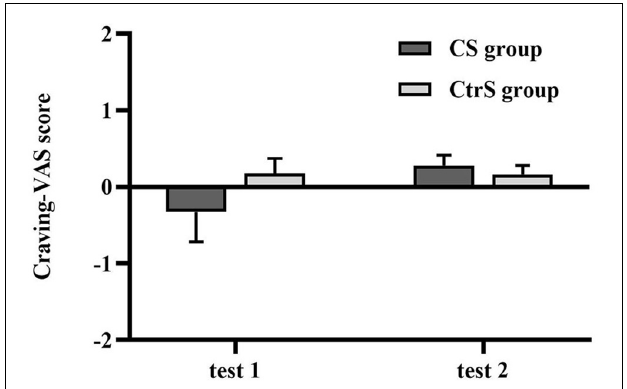
FIGURE 3 | Cue-induced alcohol craving (mean ± SEM) at baseline (test 1) and retest (test 2) for the CS group and CtrS group. These ratings were obtained from the VAS measures and were presented as change scores in craving. None of the differences were statistically significant.